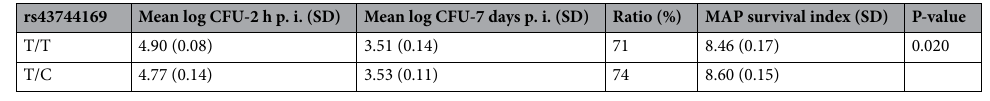
Table 5. Genotype effect on MAP survival using a macrophage killing assay. SD standard deviation, CFU colony forming